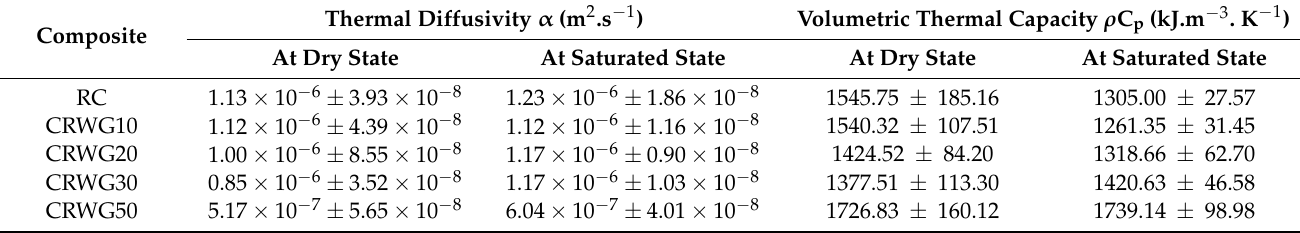
Table 6. Thermal diffusivity and volumetric thermal capacity of modified